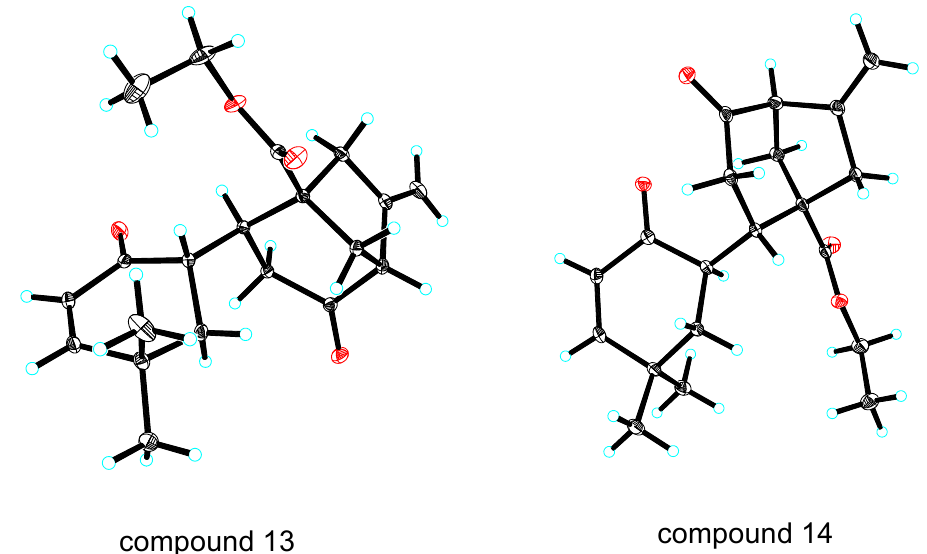
Figure 3. X-ray crystallographic analysis of compound 13 and 14 .